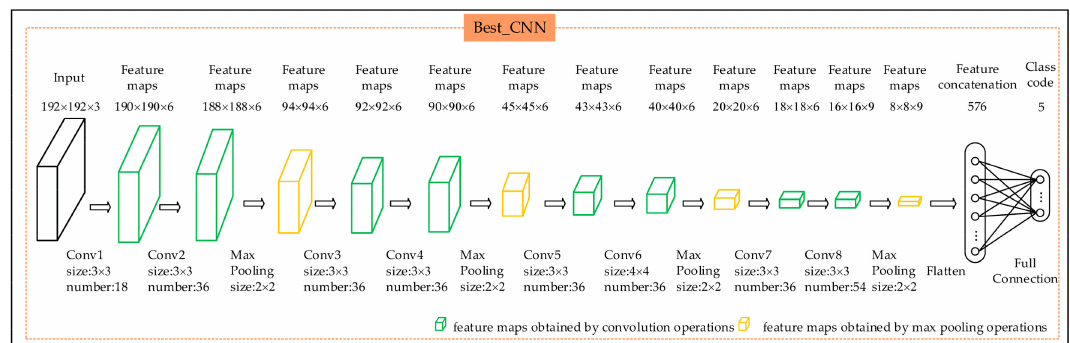
Figure 7. Architecture of the Best_CNN model (the green layers represent the feature maps obtained by convolution operations, and the yellow layers represent the feature maps obtained by max pooling